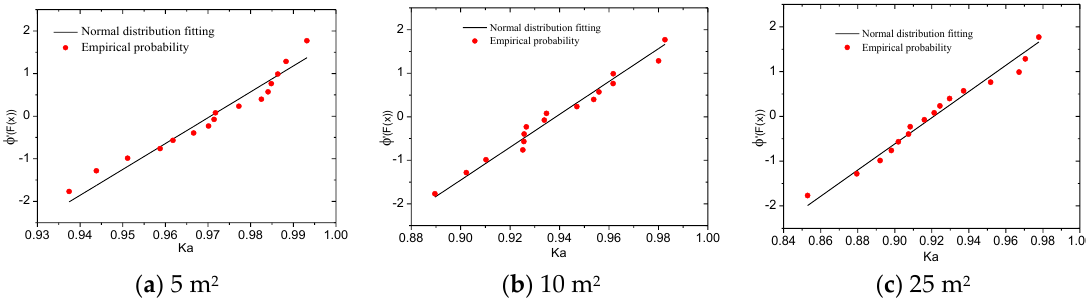
Figure 14. Fitting result of the probability distribution of K a value in different areas: ( a ) 5 m 2 , ( b ) 10 m 2 , ( c ) 25 m 2 .